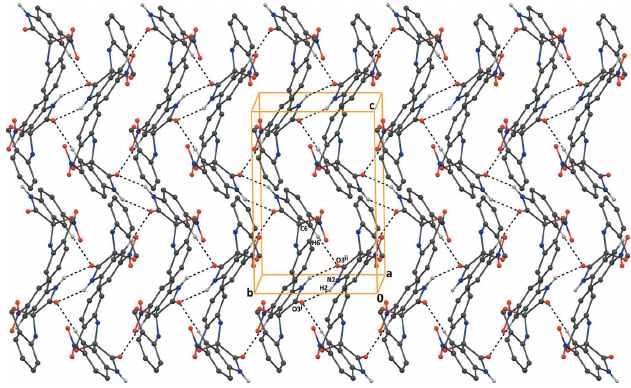
Figure 3 Part of the crystal structure showing the formation of sheets parallel to bc plane built from N—H (cid:3)(cid:3)(cid:3) O and C—H (cid:3)(cid:3)(cid:3) O hydrogen bonds and containing R 2 (8) inversion dimers. 2